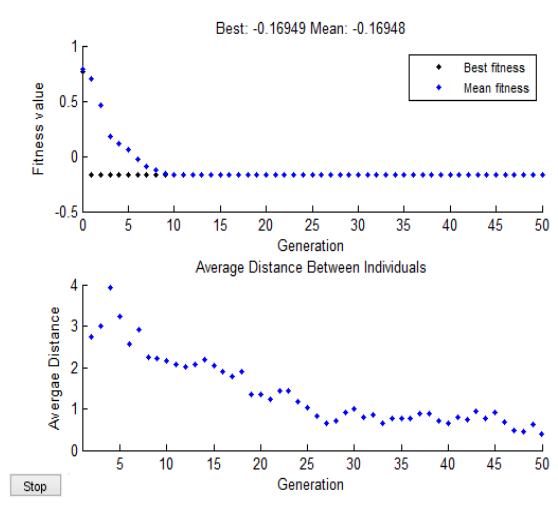
Fig. 11. Best fitness value for :; sinwave trajectory and average distance between individuals.